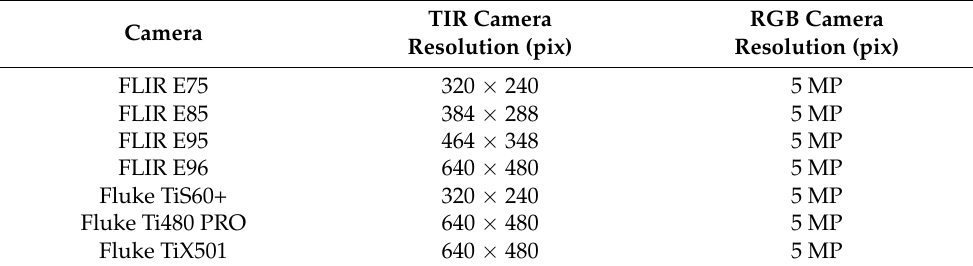
Table 1. Comparison of parameters of handheld thermal infrared cameras [15,16].